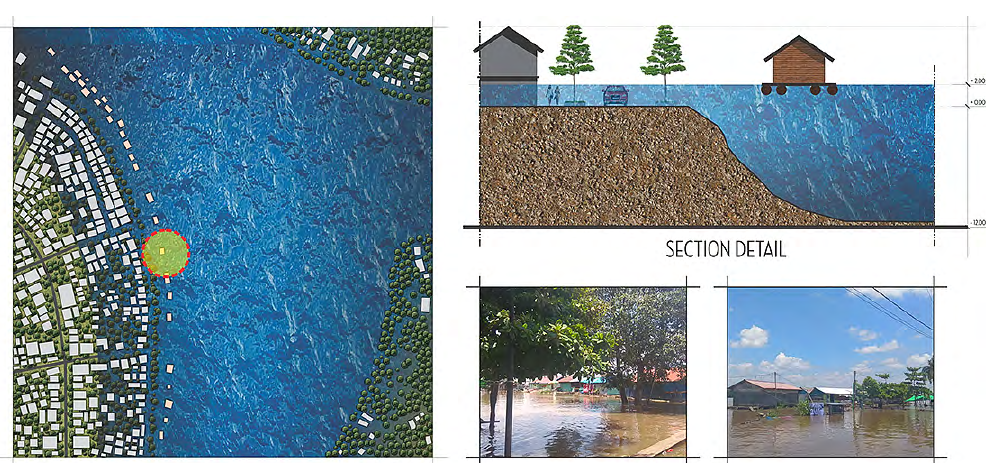
Figure 2. Flood condition of Melawi